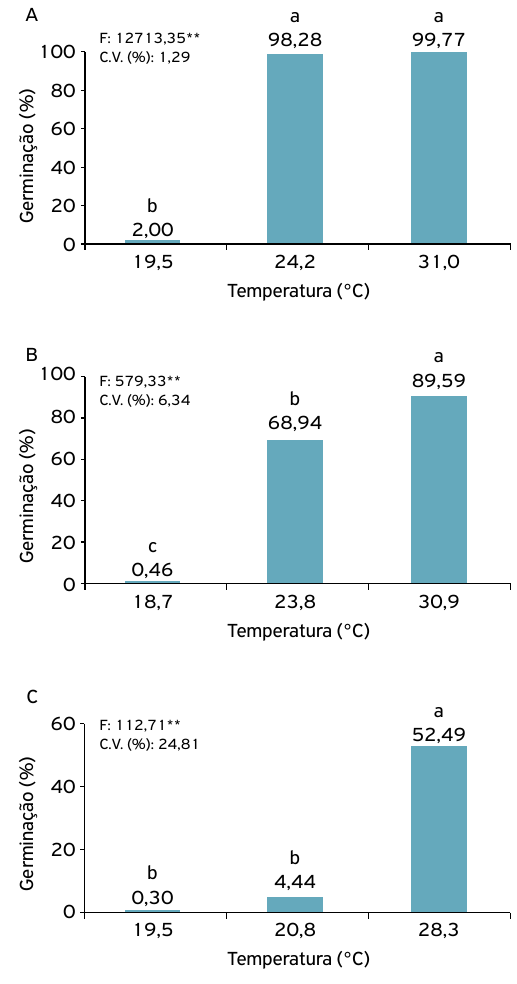
Figura 1. Germinação de conídios do isolado de Metarhizium anisopliae expostos às temperaturas mínima, mediana e máxima ocorridas no município de Jaboticabal, São Paulo, no período de novembro de 2008 a fevereiro de 2009 (A), e do isolado de Beauveria bassiana exposto às mesmas temperaturas referentes às estações climáticas da primavera e verão (B), e do outono e inverno (C), ocorridas no mesmo município, no período de março de 2008 a março de